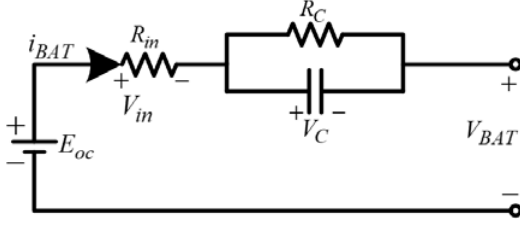
Figure 6. First order RC model of battery.